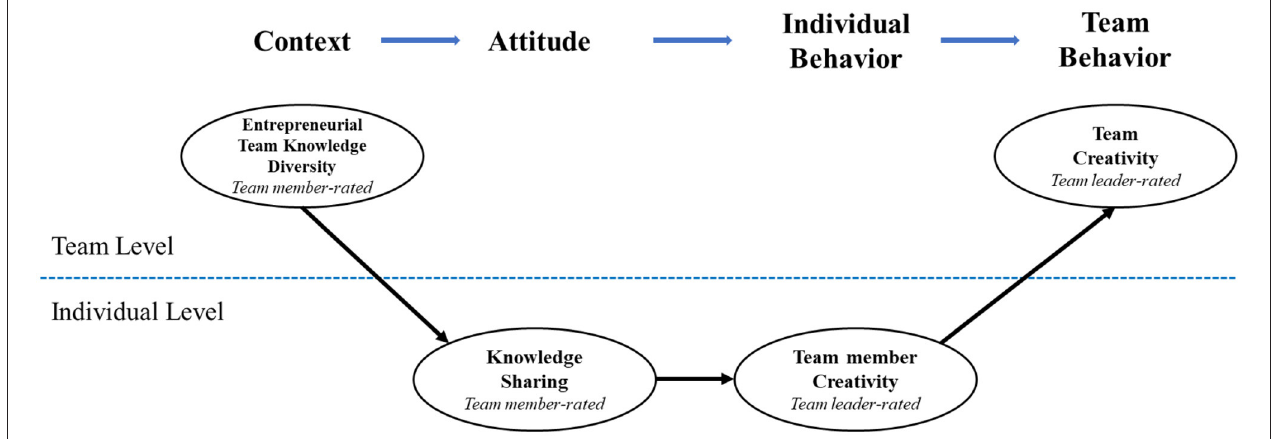
FIGURE 1 | Hypothesized